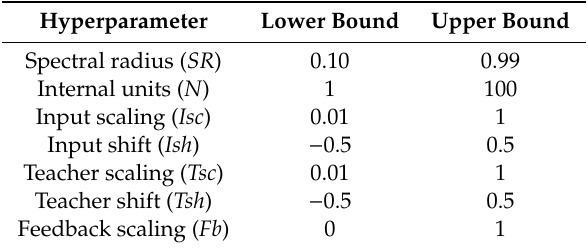
Table 1. Search space of the ESN